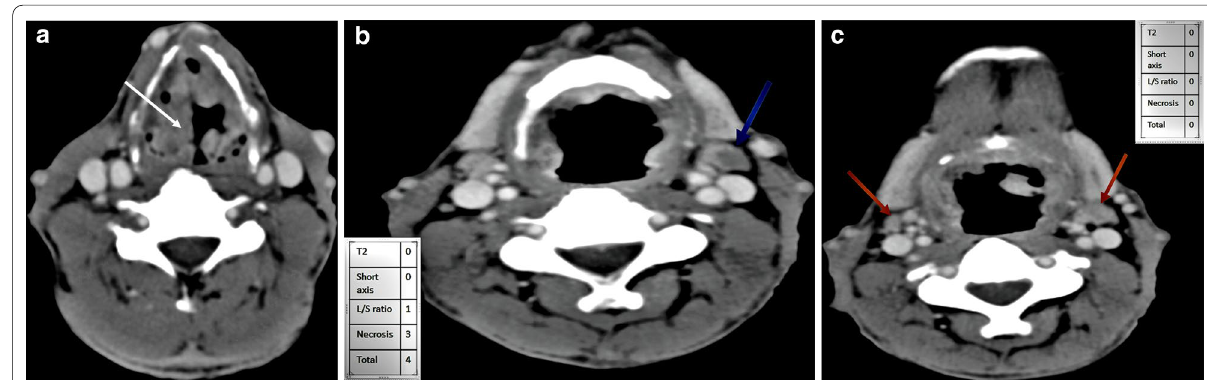
Fig. 3 A 54-year-old male SCC patient suffered from pain, ulceration, and swelling. Contrast-enhanced MDCT neck a axial view shows bilateral glottis, supra glottis, aryepiglottic folds soft tissue mass measures 30 36 20 mm (white arrow). b Axial view shows left side LN enlargement at × × level (III) measures 9 13 mm with necrosis (score 4) (sky blue arrow). c The axial view shows bilateral LN enlargements at level (II, III and IV) (score 0) × (orange arrows). Histopathology confirmed the node to be malignant at level III (sky blue arrow); others were